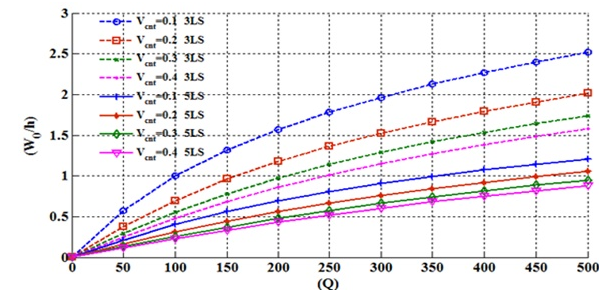
Figure 7 shows the nature of load deflection curve for linear and nonlinear analysis of [90/C/90] sandwich beam.